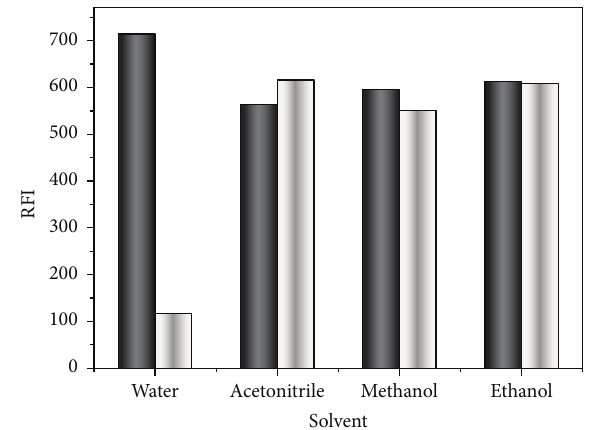
Figure 6: Effect of the diluting solvent on fluorescence intensity of PTB (40 ngmL −1 ); black column in presence of Cr RH 40; and white column in absence of Cr RH